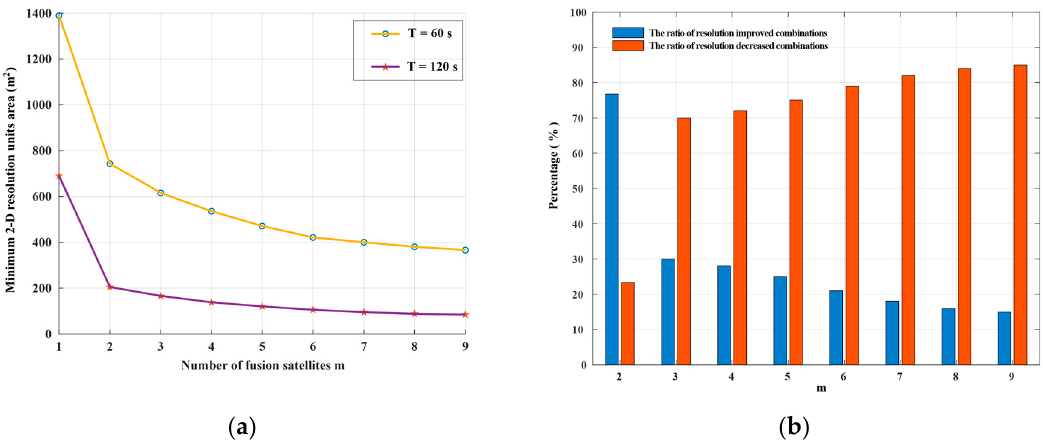
Figure 6. Two-dimensional (2-D) resolution unit area distribution of the Multi-Satellite Fusion Point Spread Function (MPSF): ( a ) A 1 ( 180 ◦ ,90 ◦ ,45 ◦ ) + A 2 ( ϕ 2 , γ 2 ,45 ◦ ) , ( b ) A 1 ( 180 ◦ ,90 ◦ ,45 ◦ ) + A 2 ( 100 ◦ ,50 ◦ ,45 ◦ ) + A 3 ( ϕ 3 , γ 3 ,45 ◦ ) .